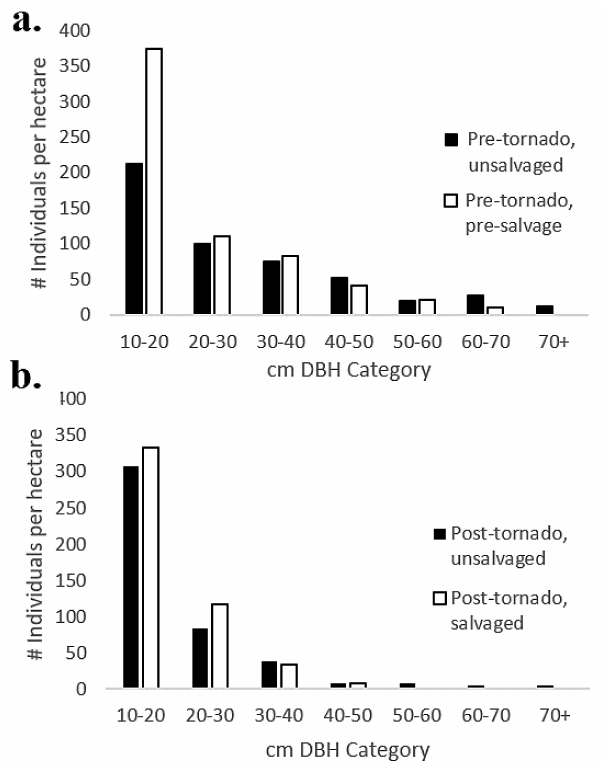
Figure 2. Frequency distributions among size (cm DBH) classes pre-tornado ( a ) and six years post-tornado ( b ) for salvaged and unsalvaged plots.